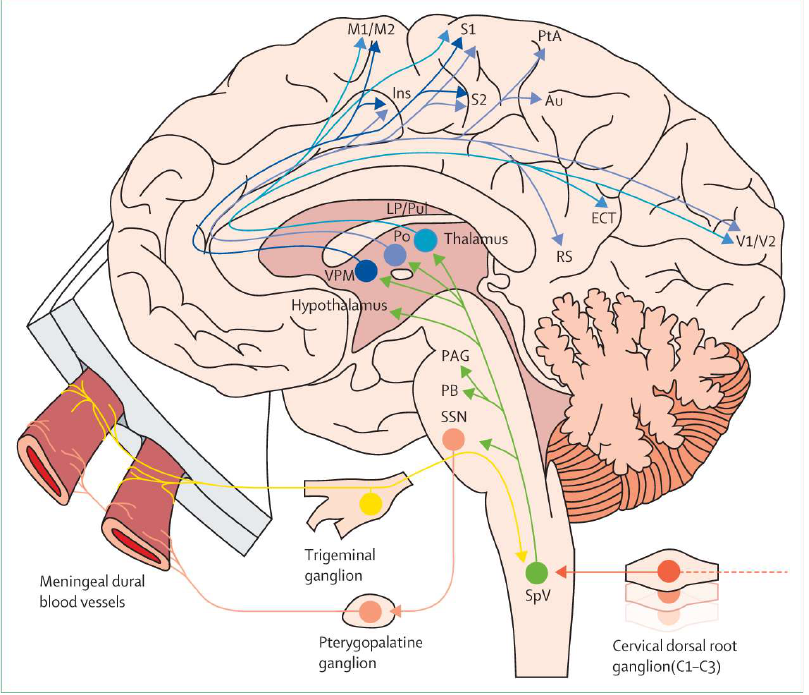
Figure 1. The complex trigeminovascular system and the activation of migraine. Sensory nociceptors innervating dural meningeal arteries undergo activation due to chemical or physical stimuli and project to second- and third-order neurons inducing migraine and sensitization. Au = Auditory cortex. ECT= ectorhinal cortex. Ins = insular cortex. LP = lateral posterior thalamic nucleus. M1 = primary motor cortex. M2 = secondary motor cortex. PAG = periaqueductal gray. PB = parabrachial nucleus. Po = posterior. PtA = parietal association cortex. Pul = pulvinar. RS = retrosplenial cortex. S1 = primary somatosensory cortex. S2 = secondary somatosensory cortex. SpV = spinal trigeminal nucleus. SSN = superior salivatory nucleus. V1 = primary visual cortex. V2 = secondary visual cortex. VPM = ventral posteromedial (adapted with permission from [6]).